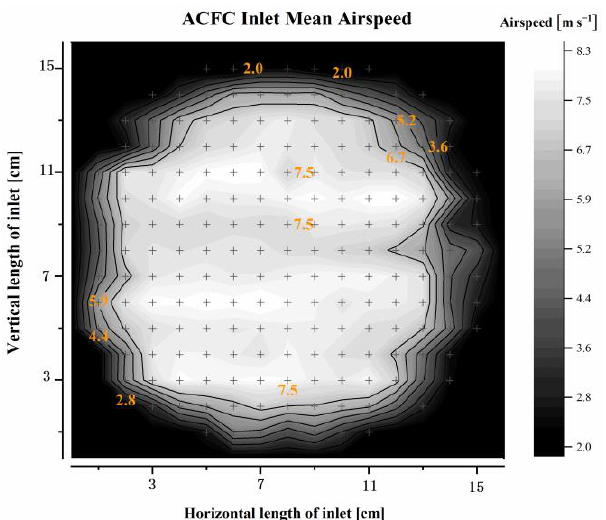
Figure 4. The distribution of airflow velocity measured under laboratory conditions. The panel shows the inlet flow field. Black dots of the cross indicate the points of measurement (mean of 10 values).